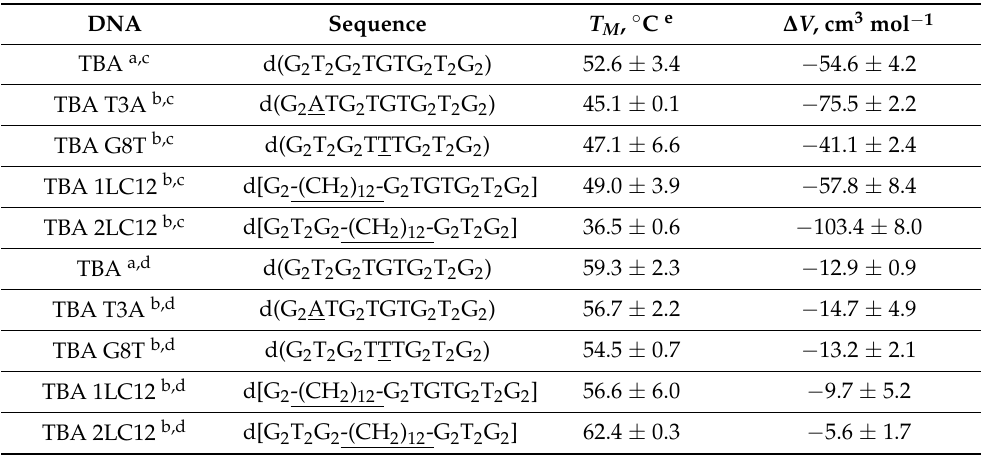
Table 3. Molar chanes in volume ( ∆ V ) accompanying the unfolding transitions of thrombin binding aptamer (TBA) and thrombin binding aptamers with altered loops determined from the pressure dependences of the unfolding temperature, T M . The values were calculated from analysis of the effect of hydrostatic pressure on the thermal unfolding of the G-quadruplex using the Clapeyron equation. For TBA 1LC12 and TBA 2LC12, a 12-carbon methylene chain replaces the nucleobases in the respective loops. The changes in the original TBA sequence are underlined.